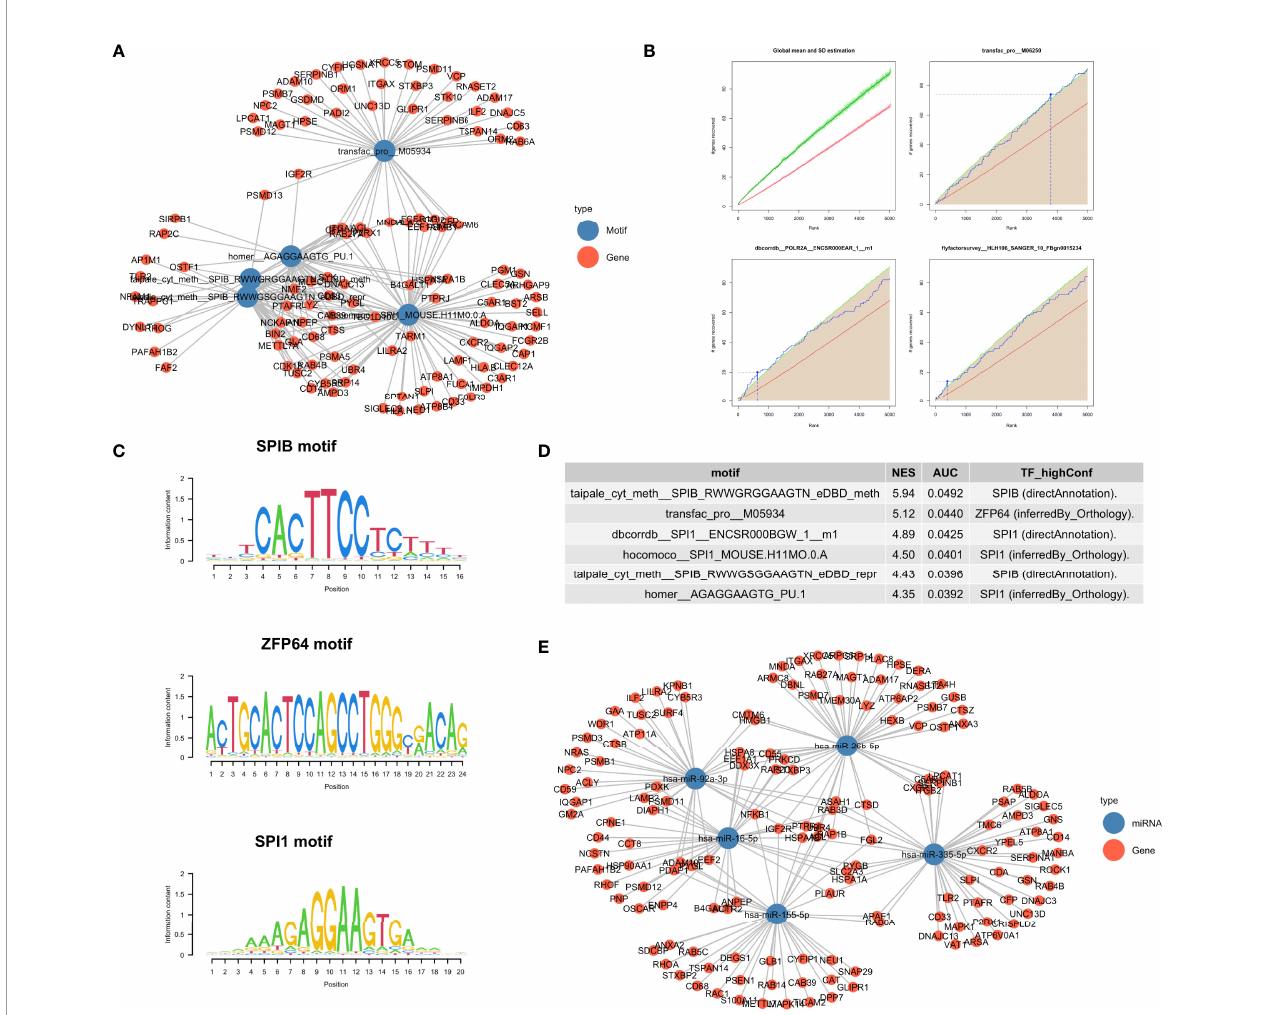
FIGURE 4 | Regulatory drivers of the turquoise module. (A) Network visualization of the enriched motifs and genes. (B) Cumulative recovery curve for several example motifs. The red line represents the global mean of the number of recovered genes and the green line represents the third standard deviation (3SD). Motifs greater than the 3SD were considered statistically signi fi cant. (C) Sequence logo of enriched motifs, the relative width of a position is represented by the information content matrix. (D) Results of the top six enrichment motifs. (E) Network visualization of the top 5 miRNA and their target genes identi fi ed from the “ mirtarbase ”